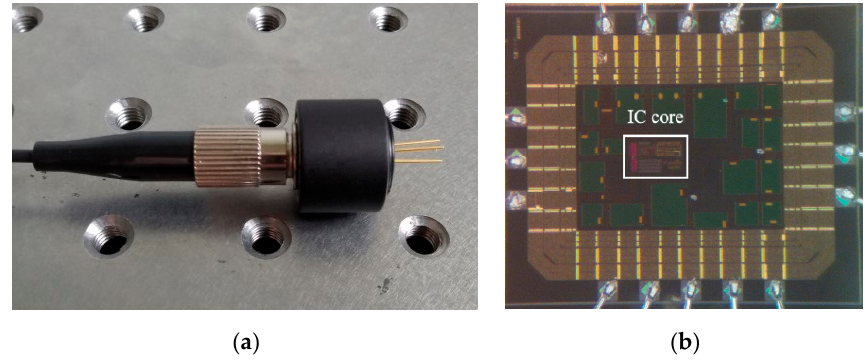
Figure 3. Photos of the custom designed and fabricated ( a ) SPAD and ( b ) AQR-IC.